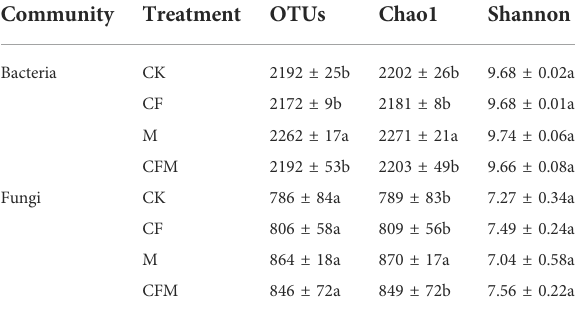
TABLE 4 Soil microbial community richness and diversity indices among the different treatments after 16 years (2004 – 2019).